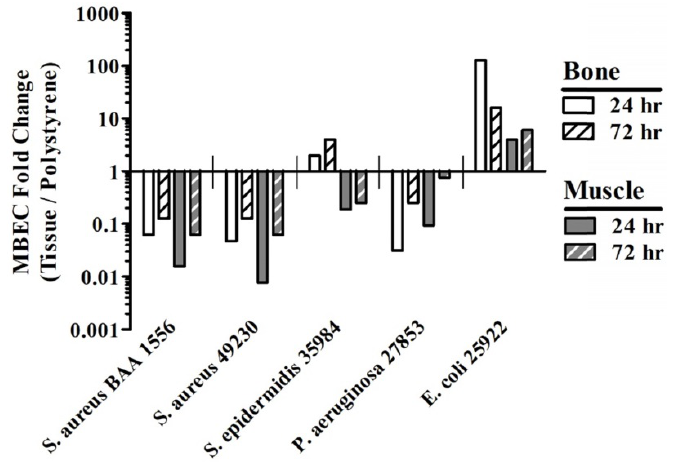
Figure 3. Fold change in MBEC for musculoskeletal biofilms on muscle or bone treated with tobramycin/vancomycin compared to MBEC on